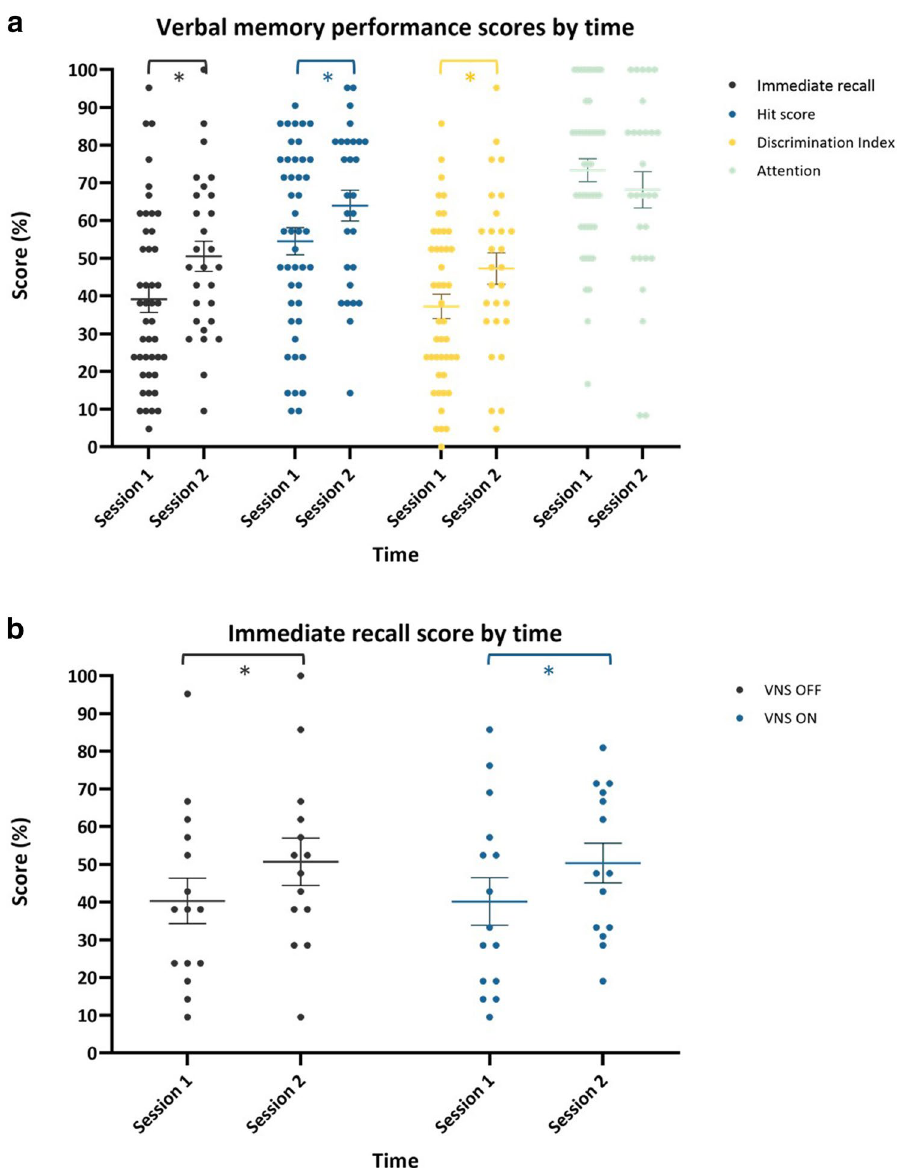
Figure 4. Verbal memory performance by time ( a ) and immediate recall performance by time and intervention ( b ). ( a ) A significant increase in immediate recall score ( p = 0.001), hit score ( p = 0.004) and discrimination index ( p = 0.007) was seen in session 2 compared to session 1. ( b ) No interaction effect of time*intervention was seen, indicating memory performance increased over time irrespective of the experimental conditions, as demonstrated here for immediate recall score. Error bars indicate group mean ± SE. Significant findings are indicated by an